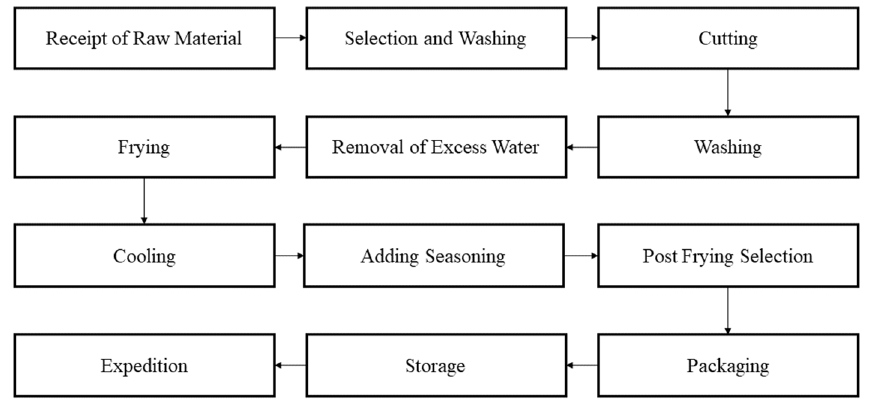
Figure 2. Potato production process.